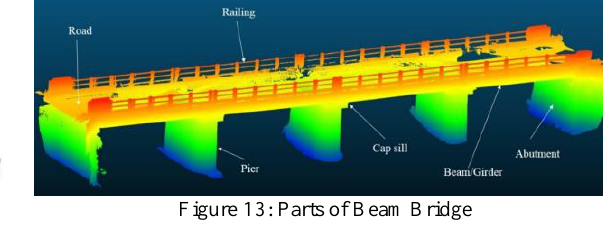
Figure 12: Bottom drawing of Beam Bridge Some parts of the Beam Bridge are shown in the figure 13.